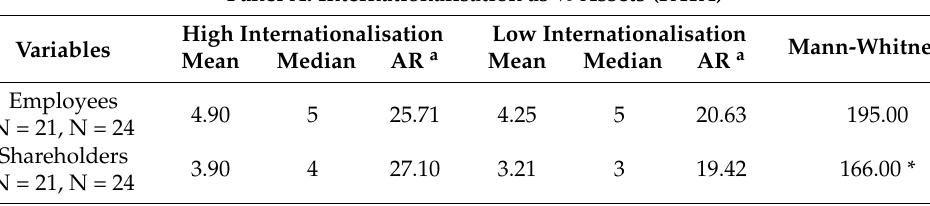
Table 6. Comparative analysis of CSR indicators for Employess and Shareholders and Internationalisation. Panel A: Internationalisation as % Assets